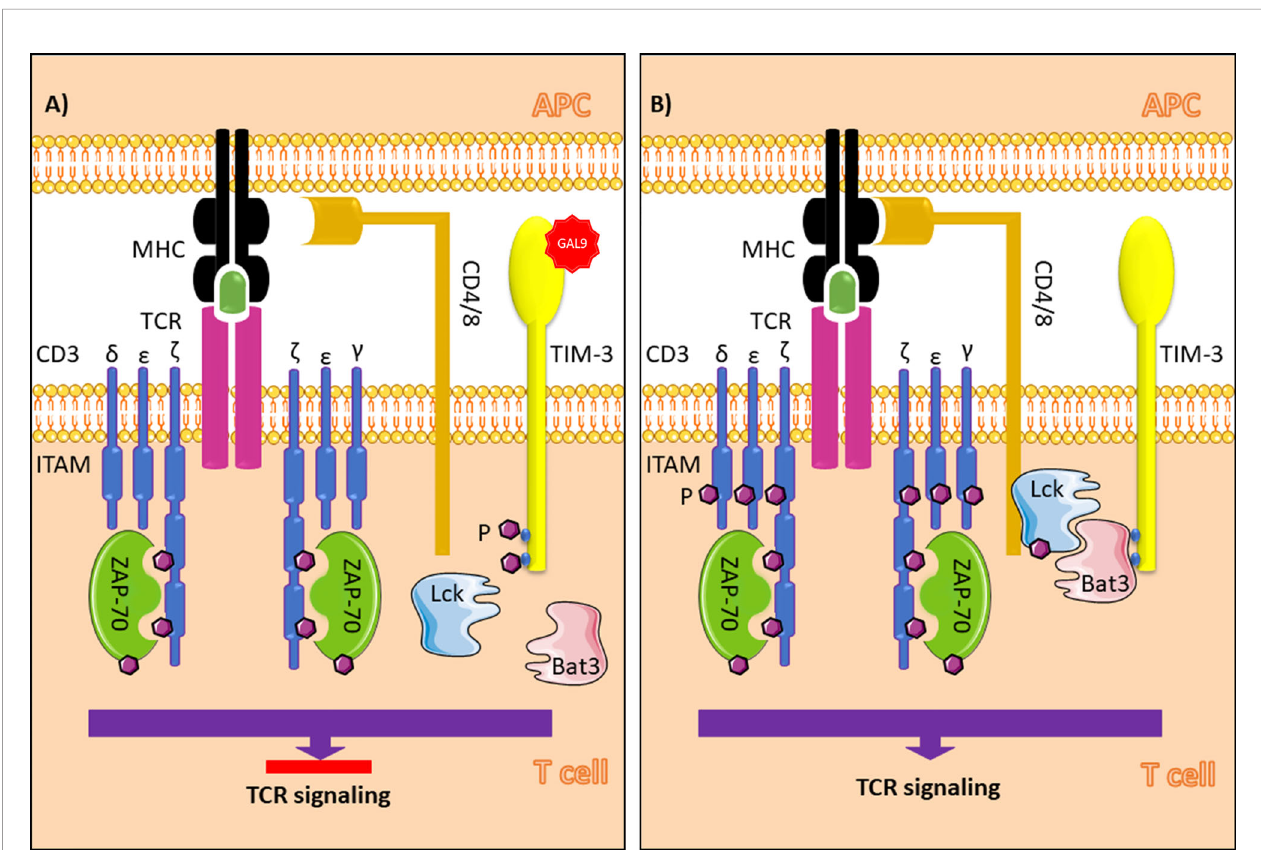
FIGURE 1 | TIM-3 signaling in T cells in the presence (A) and absence (B) of galectin-9. In the absence of Gal-9, Bat3 binds to tyrosine residues in the cytoplasmic tail of TIM-3 (Y256 and Y263 in mice and Y26 and Y272 humans). This process leads to accumulation of the active form of Lck, which promotes phosphorylation of Zap70 and T cell signaling when the MHC peptide-TCR complex is formed. In the presence of Gal-9, as the ligand for TIM-3, phosphorylation of the tyrosine residues results in Bat3 release from the cytoplasmic tail. In this paradigm, Bat3 cannot form a complex with Lck; thus, TIM-3 induction inhibits T cell signaling. TIM- 3, T cell immunoglobulin and mucin domain-3; Gal-9, galectin-9; Bat3, HLA-B associated transcript 3; TCR, T cell receptor; ITAM, immunoreceptor tyrosine-based activation motif; APC, antigen presenting cell; MHC, major histocompatibility complex; Ag, antigen. The fi gure was produced with the assistance of Servier Medical Art